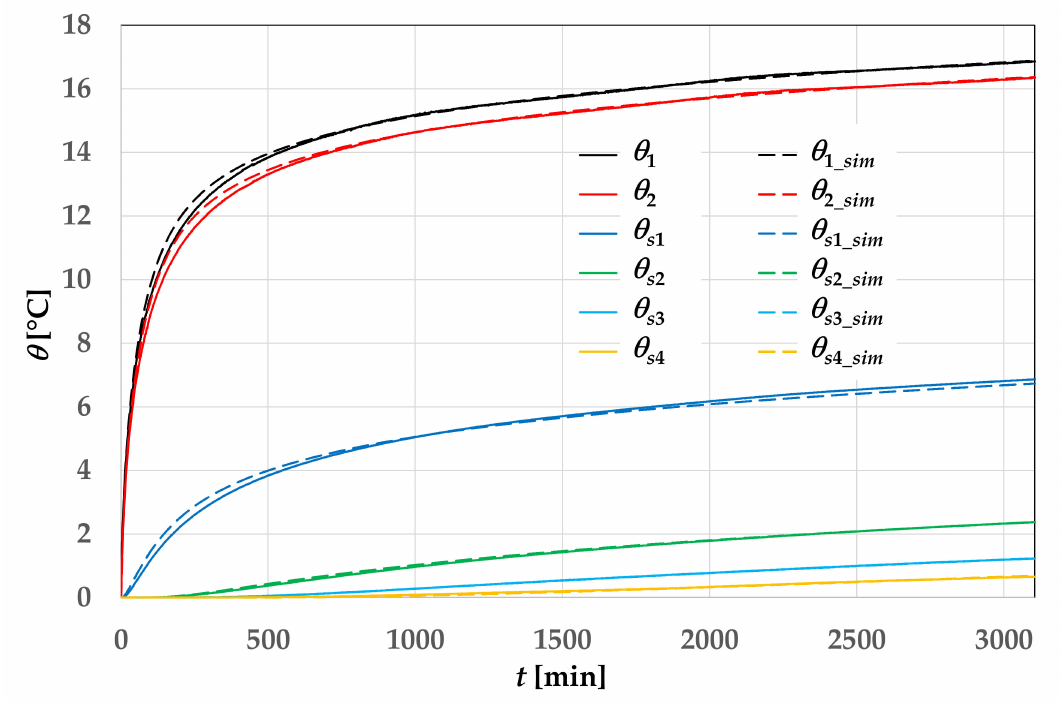
Figure 10. Time evolution of the temperature rise in the fluid and in the sand: experimental values ( θ 1 , θ 2 , θ s 1 , θ s 2 , θ s 3 , and θ s 4 ) and simulated values ( θ 1_ sim , θ 2_ sim , θ s 1_ sim , θ s 2_ sim , θ s 3_ sim , and θ s 4_ sim ), for k g = 0.863 W/(mK), ( ρ c ) g = 3.8 MJ/(m 3 K), k s = 3.22 W/(mK), and ( ρ c ) s = 3.0667 MJ/(m 3